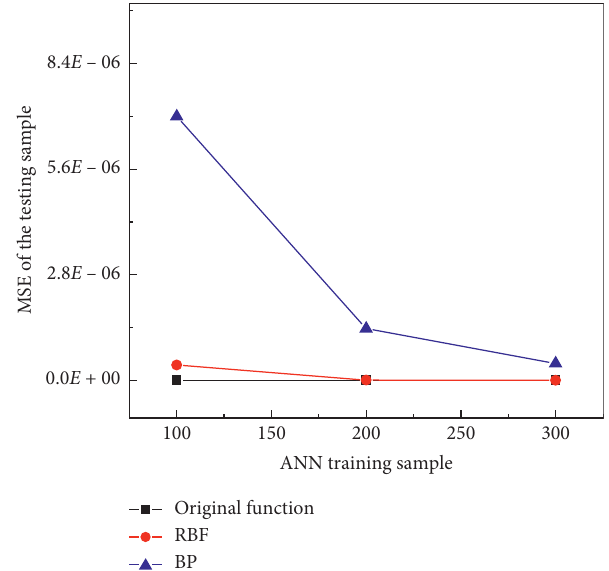
Figure 5: Comparison the change of MSE between RBF and BP as the ANN sample data size